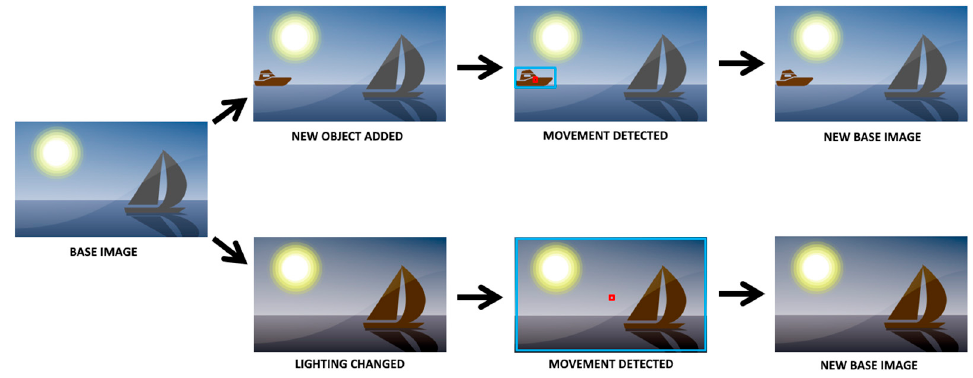
Figure 19. Creation of the new base image.